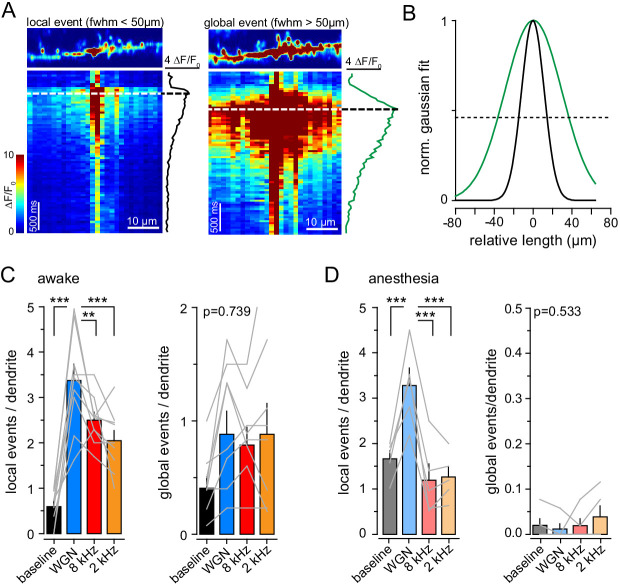
Auditory-evoked calcium events in dendritic tufts are similar between brain states.(A) Top, example of single-dendrite local (left) and global (right) Ca2+ events. Bottom, raster plot of ΔF/F0 for multiple ROIs along the dendrite represented above. Right, average ΔF/F0. Dashed line, time point of the maximum peak amplitude of averaged ΔF/F0. (B) Gaussian fits (normalized to max) of the local (black) and global (green) Ca2 events shown in (A). (C, D) number of local (left) and global (right) Ca2+ events observed during baseline and upon auditory stimulations in awake (E) and anesthetized (F) mice (n = 9 and 5, respectively). p<0.001, one-way repeated measures anova: **, p<0.01; ***, p<0.001, (Holm-Sidak multiple comparisons). Gray lines represent individual mice.Figure 2—figure supplement 1—source data 1.Number of dendritic calcium events.